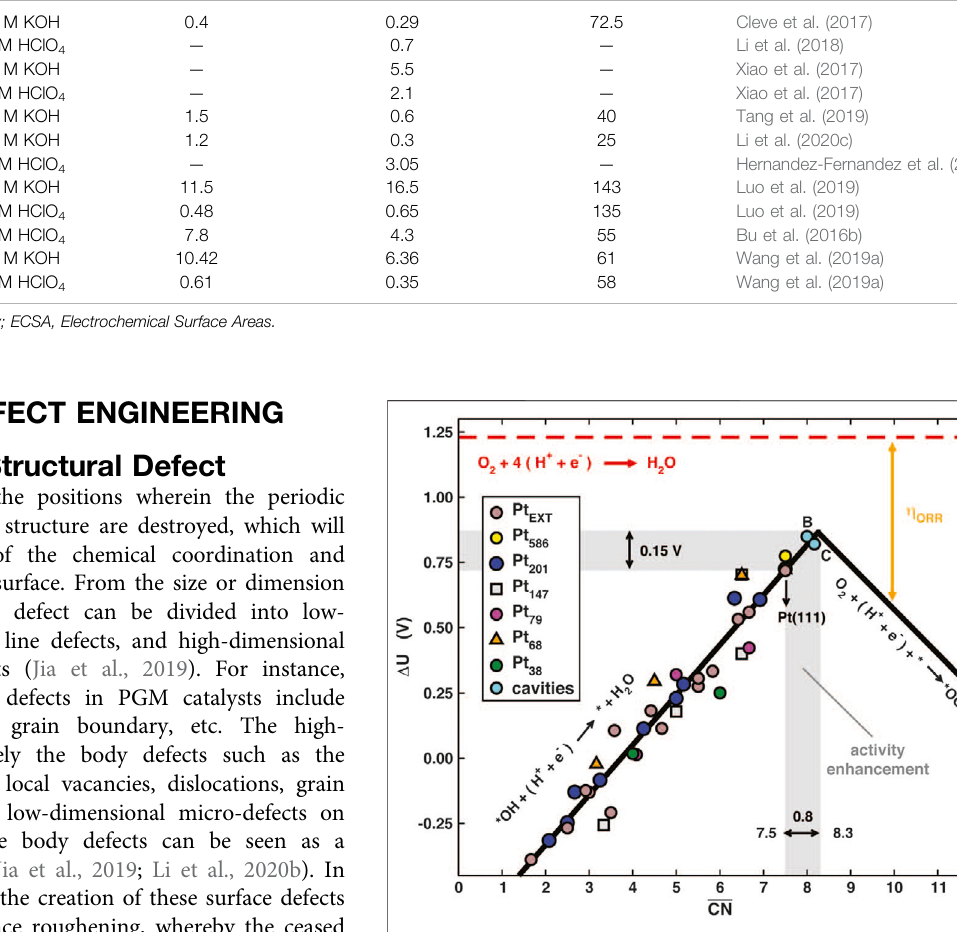
TABLE 3 | Summarized examples employing strain engineering for ORR studies. Catalyst Electrolyte